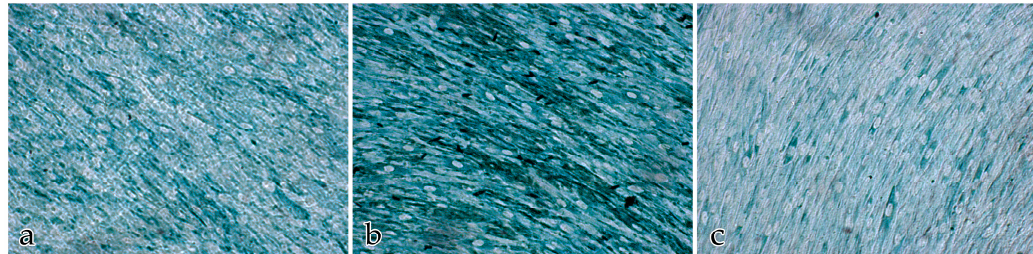
Figure 10. Immunolocalization of the ECM proteins collagen III, fibronectin, and laminin in FB monocultures after 14 days: ( a ) immunolocalization of collagen III; ( b ) immunolocalization of fibronectin; ( c ) immunolocalization of laminin. Magnification ×20.